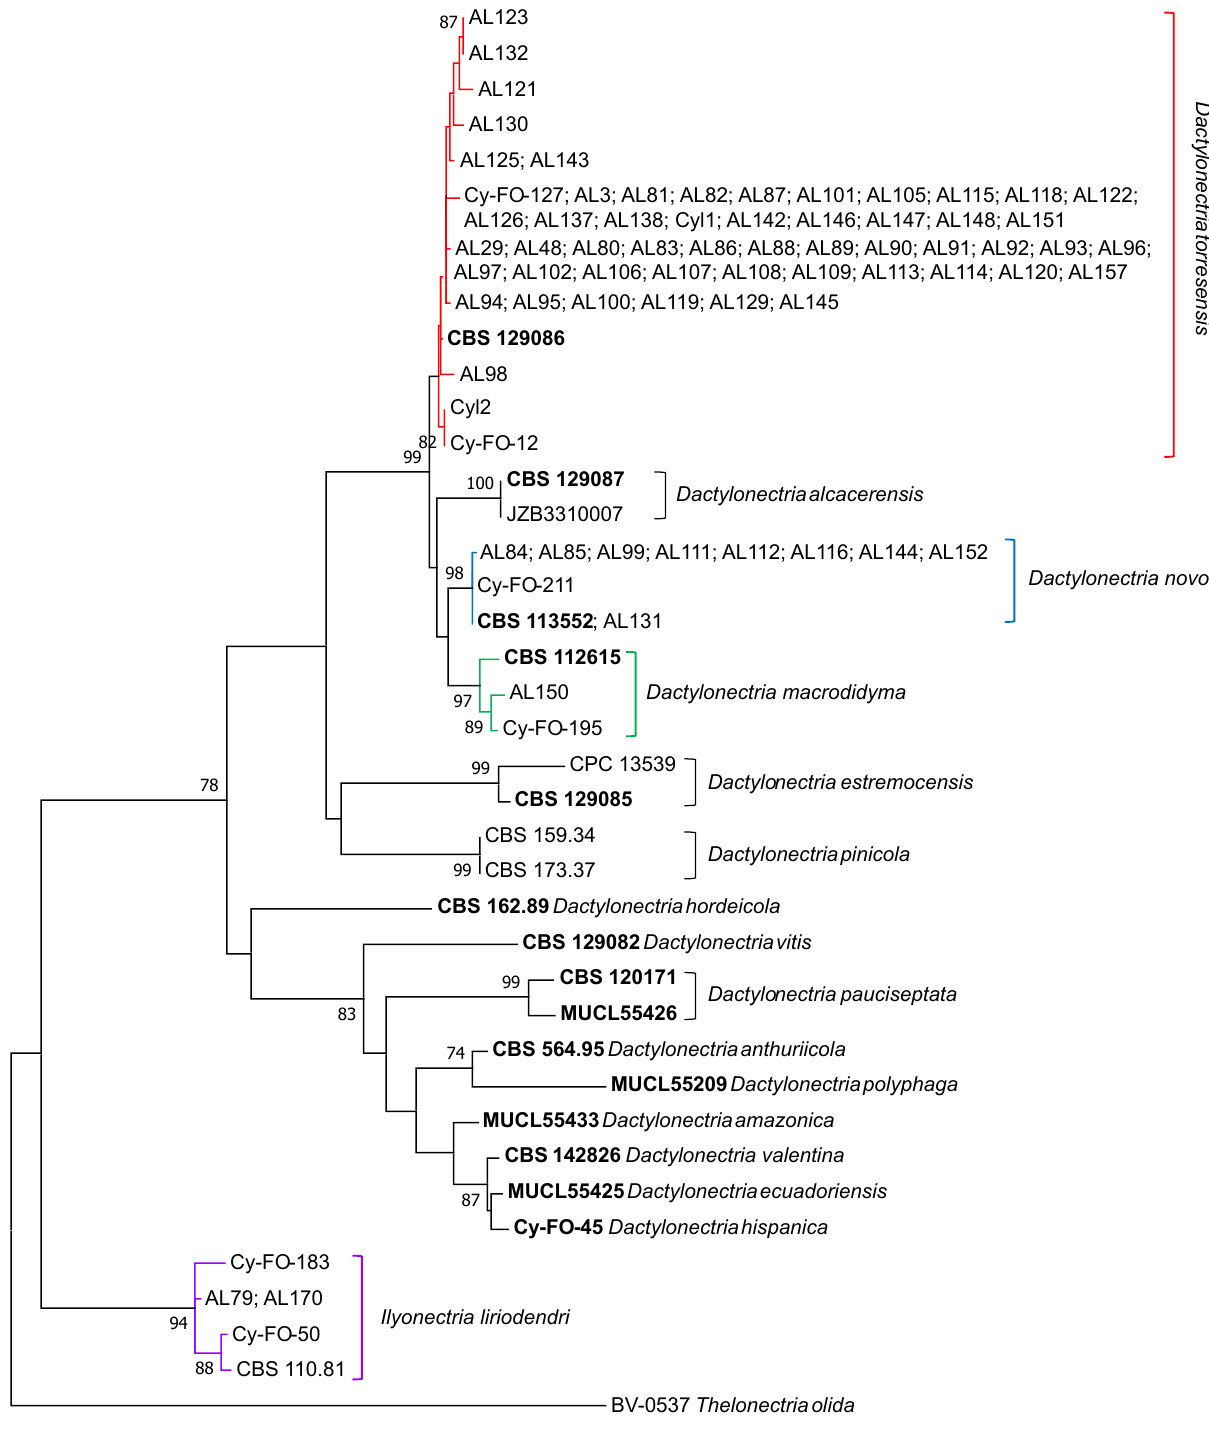
Figure 1. Phylogenetic Maximum Likelihood tree of Cylindrocarpon -like anamorphs isolated from nursery almond rootstocks and retrieved from the Genbank (ex-type cultures in bold), based on the his3 partial sequences (617 positions including gaps) using the general-time-reversible (GTR) model with a rate of variation across sites (+G) and a proportion of invariable sites (+I). Support for internal branches was assessed by 1000 mL bootstrapped pseudoreplicates of data. Nodes with bootstrap support higher than 70% were indicated in the final tree. The tree with the highest log likelihood is shown. The tree was rooted to Thelonectria olida BV-0537 isolate. The scale bar indicates 0.05 expected changes per site. Evolutionary analyses were conducted in